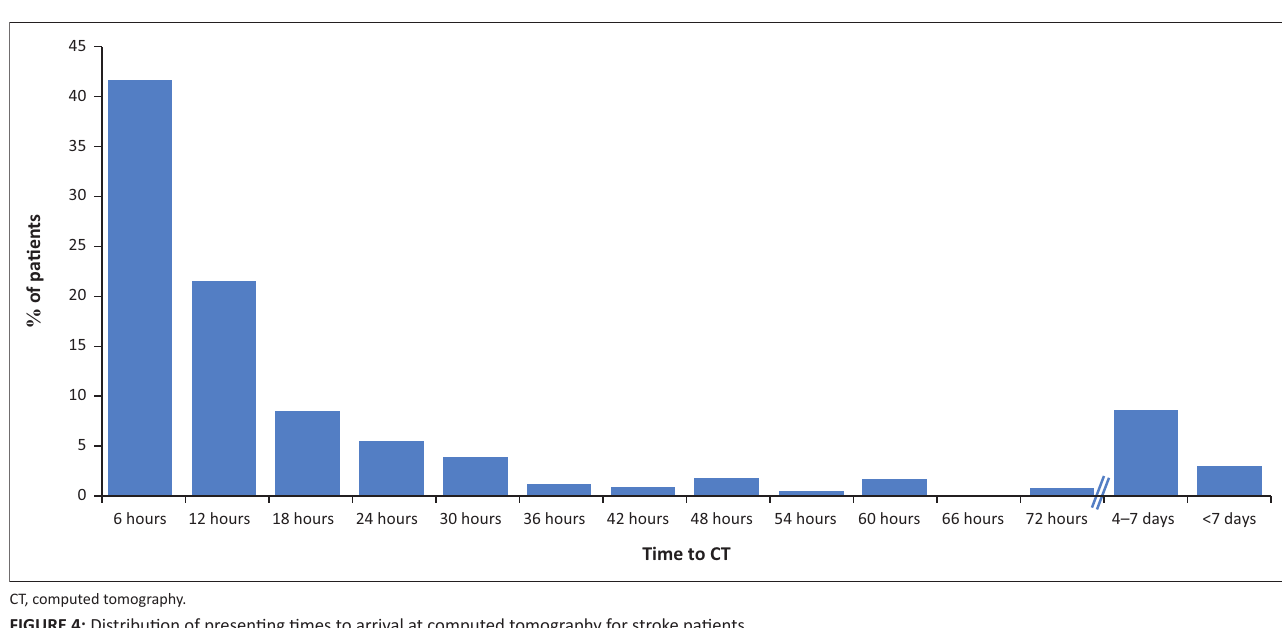
FIGURE 3: Distribution of presenting times for stroke patients to the emergency department.